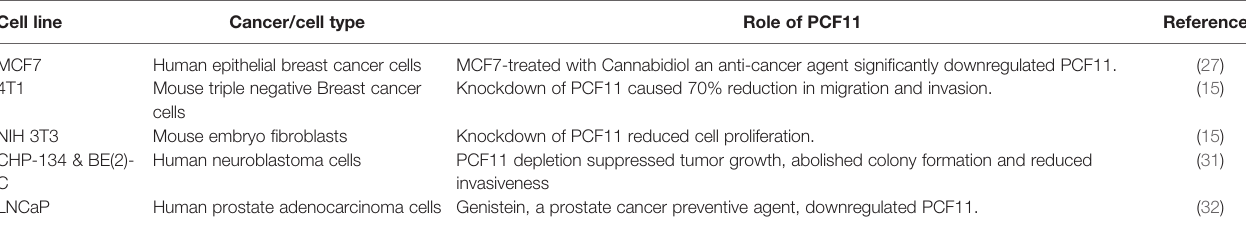
TABLE 1 | Summary of the role of PCF11 in different